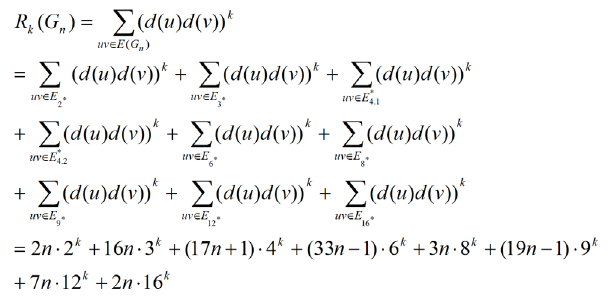
: n = 1. 1 Figure 2: Corresponding molecular graph G : n = 1. 1 : n = 1. 1